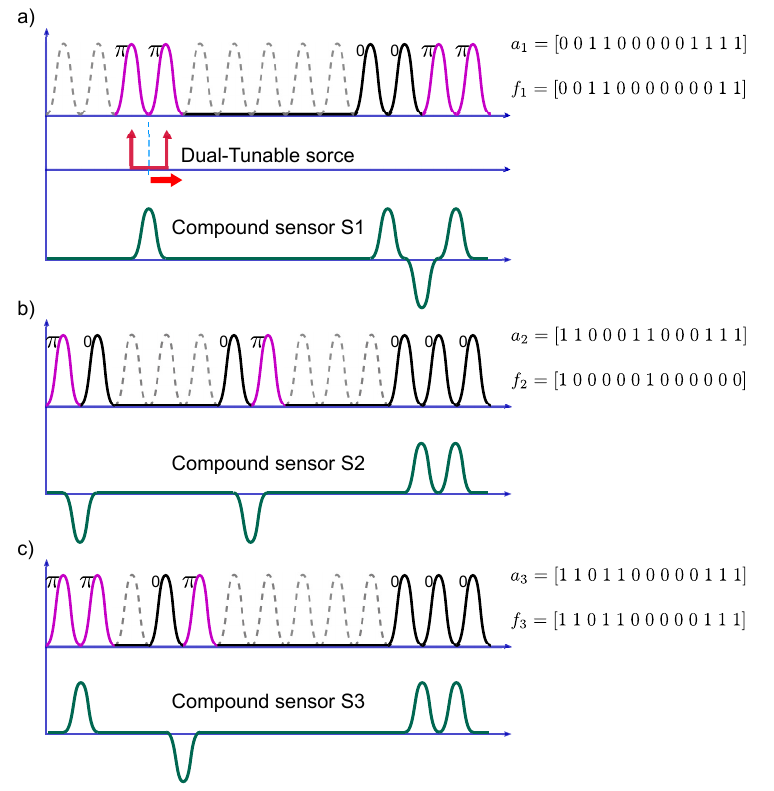
Figure 2. Set of three independent sensors designed according to the amplitude and phase codewords reported in Table 1. ( a – c ) depict the wavelength sub-band distribution for each super-structured fiber Bragg grating (SSFBG) device as well as their compound signals after interrogation through the dual-wavelength scanning. Table 1. Set of three sensors represented by their amplitude and phase